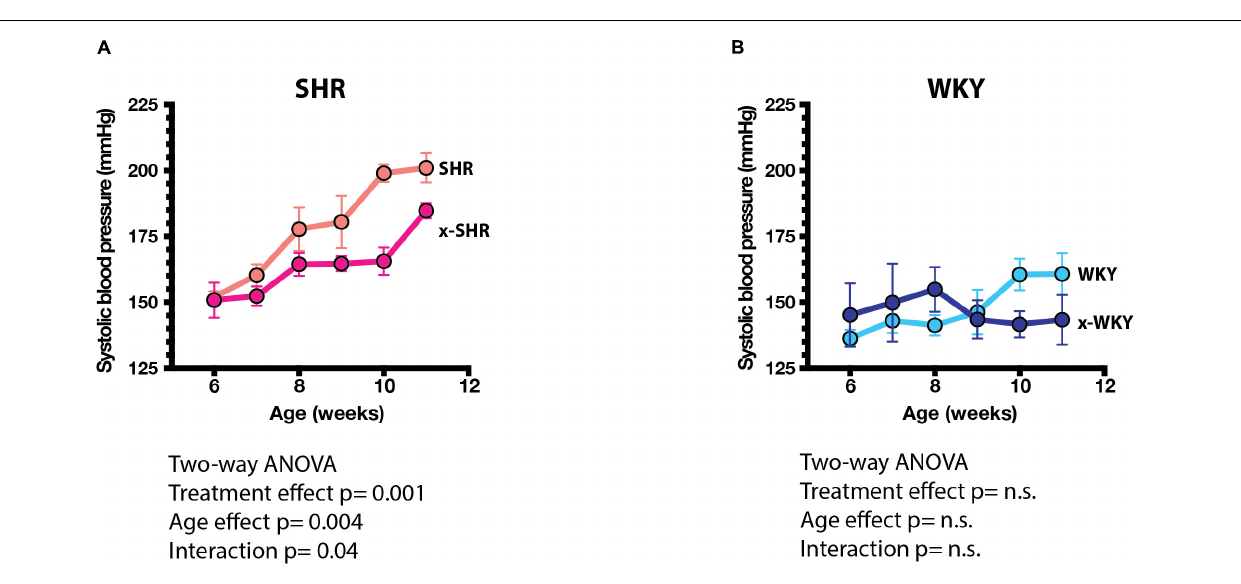
FIGURE 3 | (A) Systolic blood pressures (SBP) of self-fostered SHR vs. cross-fostered SHR, and (B) self-fostered vs. cross-fostered WKY at different ages. SBP was significantly lower in cross-fostered than self-fostered SHR. Results were analyzed by two-way ANOVA as